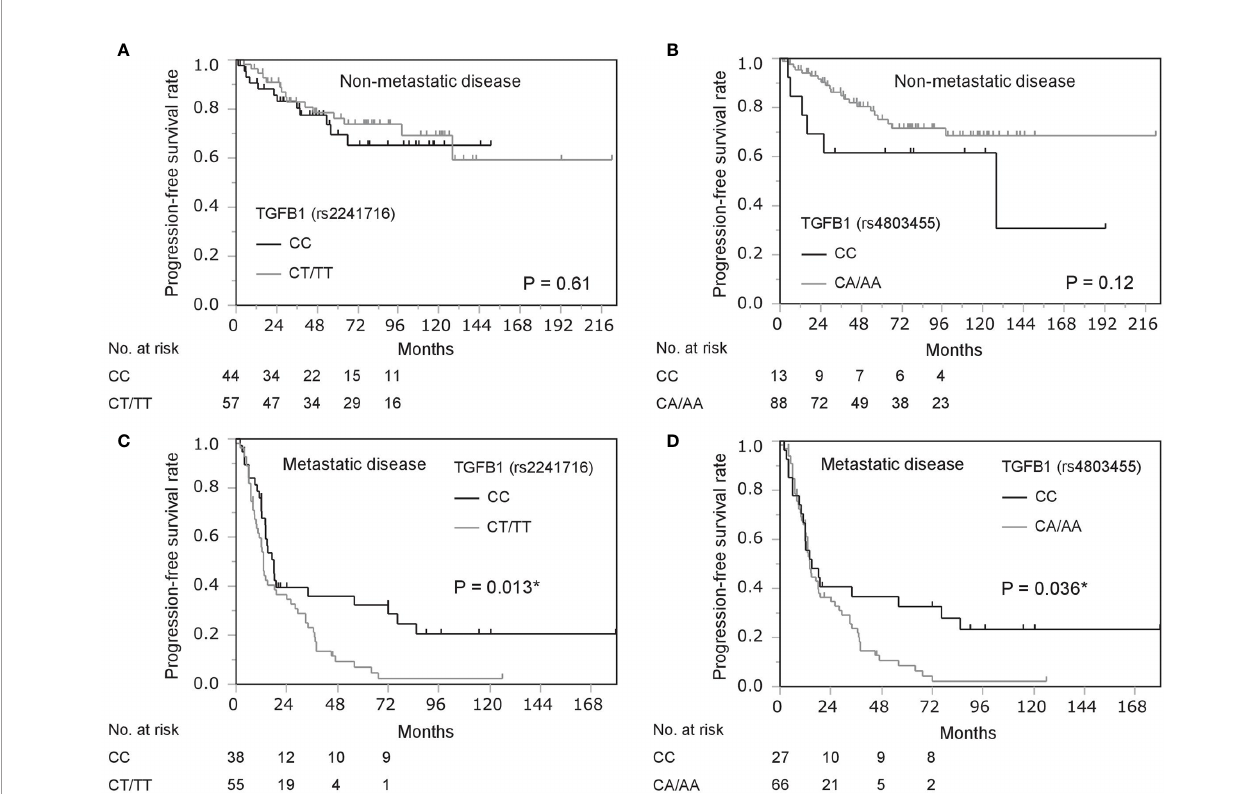
FIGURE 1 | Kaplan – Meier survival analysis of progression-free survival in prostate cancer patients strati fi ed by gene polymorphisms in TGFB1 (rs2241716 and rs4803455). (A, B) Progression-free survival in patients with non-metastatic disease by gene polymorphisms in TGFB1 [rs2241716 (A) and rs4803455 (B) ]. (C, D) Progression-free survival in patients with metastatic disease by gene polymorphisms in TGFB1 [rs2241716 (C) and rs4803455 (D) ]. *Statistically signi fi cant.